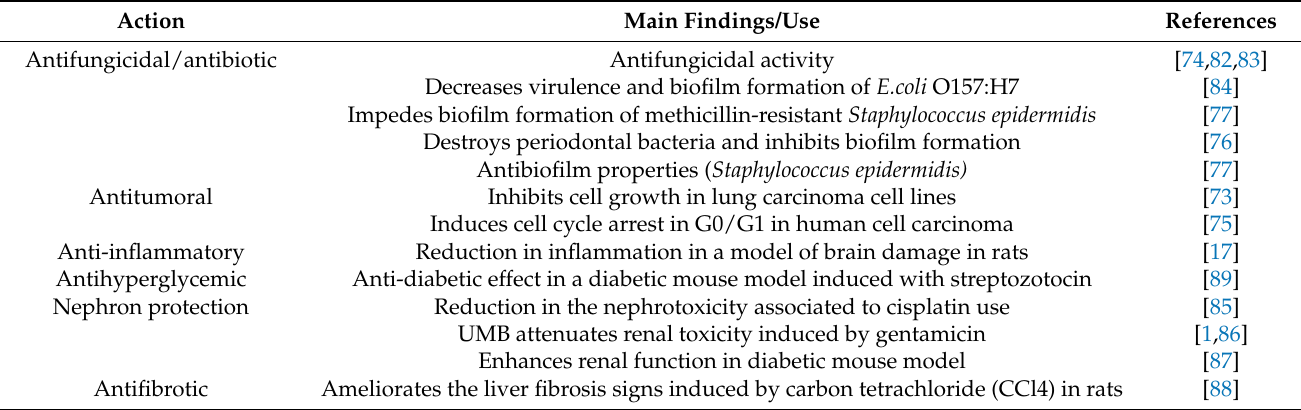
Table 5. Main actions of coumarins and their